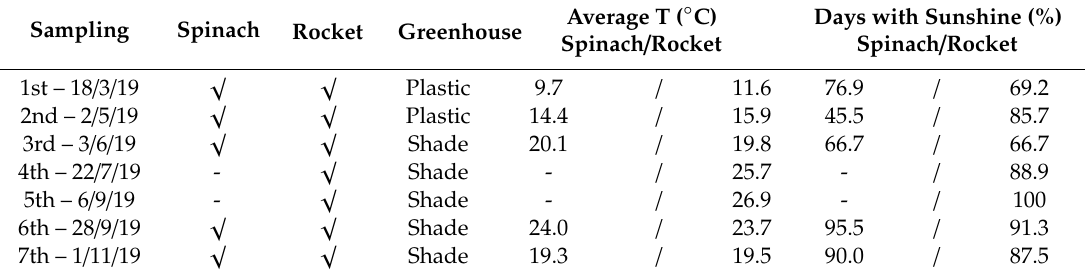
Table 1. Sampling dates for baby leaves as well as the average temperature, percentage of sunshine days, and the type of greenhouse that was used during their